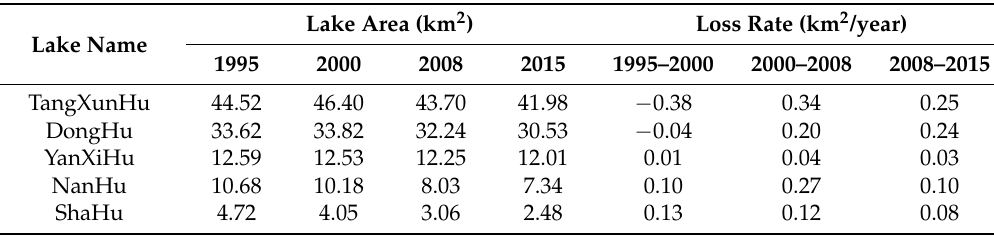
Table 4. Lake-water extent changes of typical urban lakes.